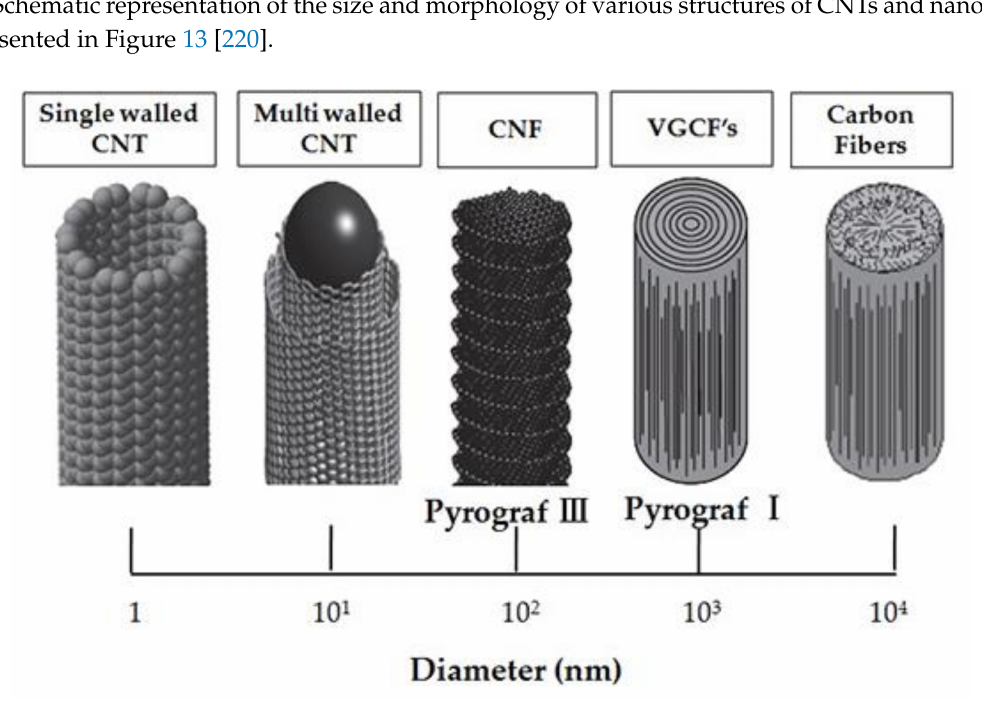
Figure 13. Schematic representation of the size and morphology of various structures of carbon nanotubes and nanofibers.